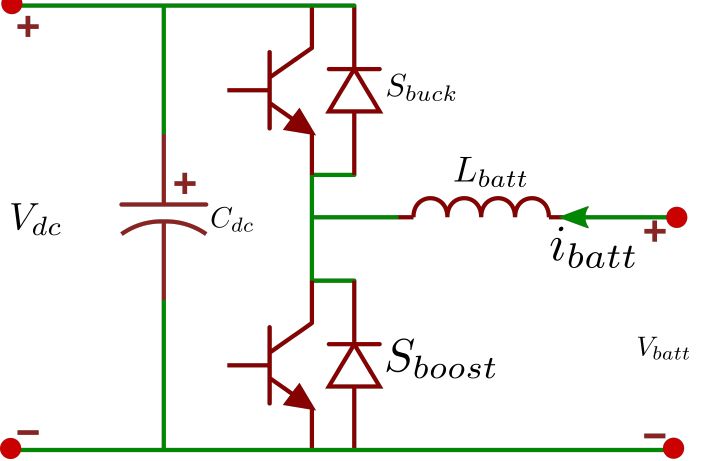
Figure 5. Equivalent circuit of the bi-directional off-board charger.